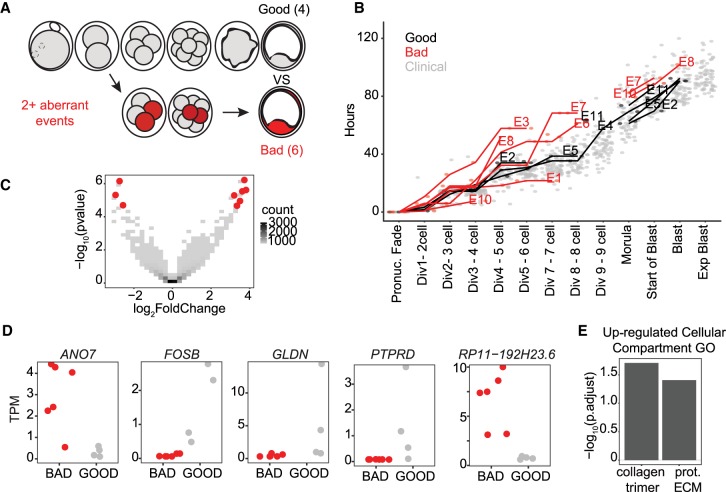
Morphokinetic quality-associated gene sets. (A) Schematic indicating the morphokinetic differential analysis (six low-quality vs. four high-quality embryos). Low quality is defined as deviance by >1 SD from clinical standard in two or more measurements. (B) Comparison of morphokinetic data from embryos in this analysis (red indicates low-quality embryos; black, high quality) to clinical-standard embryos (gray): y-axis is time in hours; x-axis, sequential series of divisions and other embryological events measured from the time of pronuclei fade. (C) Volcano plot of differentially expressed genes from morphokinetic-based differential expression analysis. Red indicates significant differential expression (BH-adjusted P-value <0.05). (D) Jitter plots of selected significant differentially expressed genes from the morphokinetic-based differential expression analysis (adjusted P-value <0.05). (E) Cellular compartment GO analysis from genes up-regulated in embryos that meet clinical standards for morphokinetics.